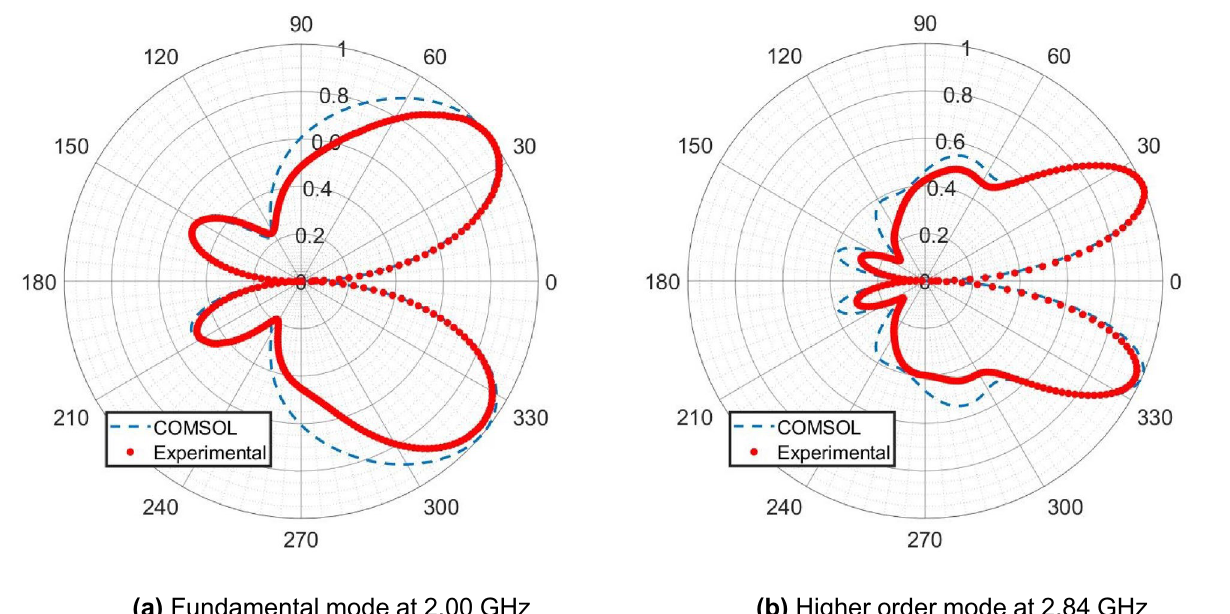
Figure 4. Polar plots of the normalised far-field radiation patterns in the x-y plane for the system at the identified ( a ) fundamental and ( b ) higher order mode, comparing computational and experimental data. The axis of the quarter-wavelength rod emitter is aligned with the 0° direction, and the ground plane is aligned along the 90°-to-270°